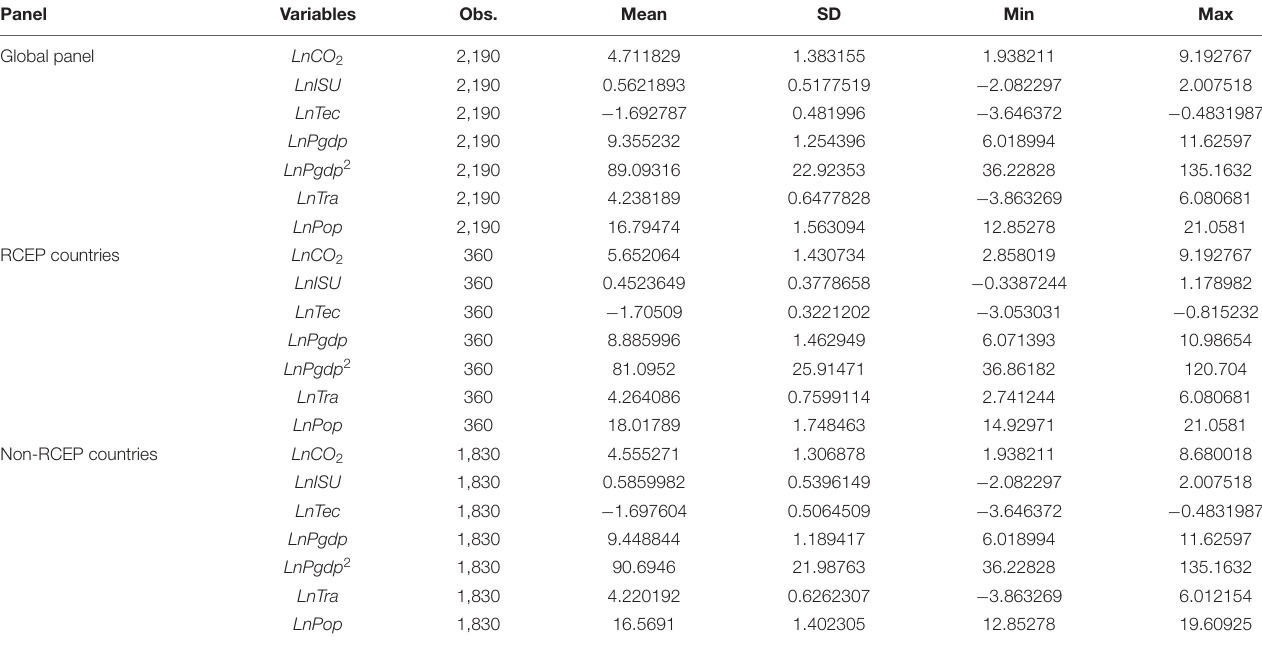
TABLE 2 | Descriptive statistics of all the selected variables (after